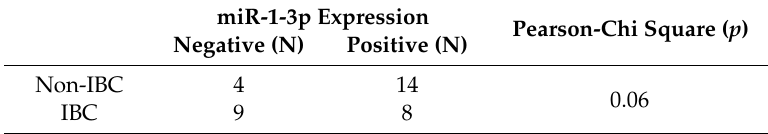
Figure 6. Expression and diagnostic value of miR-1-3p in carcinoma tissues of non-IBC and IBC in comparison with normal breast tissue samples. ( A ) miR-1-3p expression level is not altered in carcinoma tissues of IBC ( n = 8) relative to normal breast tissues ( n = 3) and non-IBC ( n = 14) as determined by qPCR. miR-1-3p expression is log2-transformed and normalized to values of normal tissues collected during reduction mammoplasty. ( B ) ROC curve generated using expression levels of miR-1-3p to discriminate between patients with non-IBC and IBC. Table 5. miR-1-3p expression detection in carcinoma tissues of IBC as compared to non-IBC.